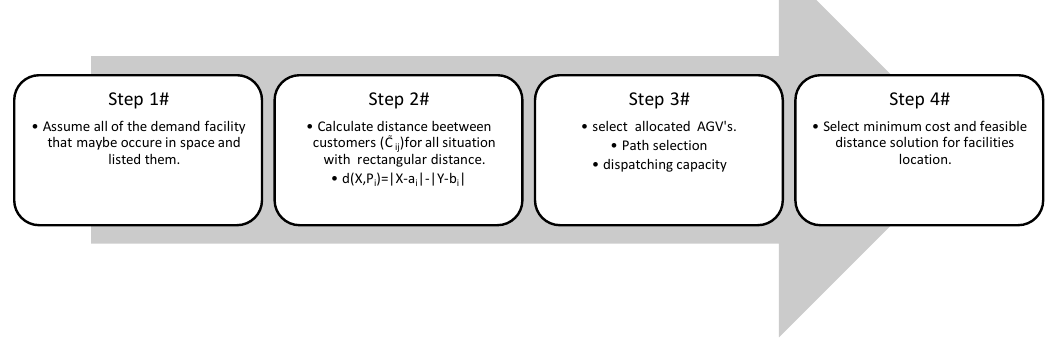
Fi g. 4. Steps of the proposed algorithm.